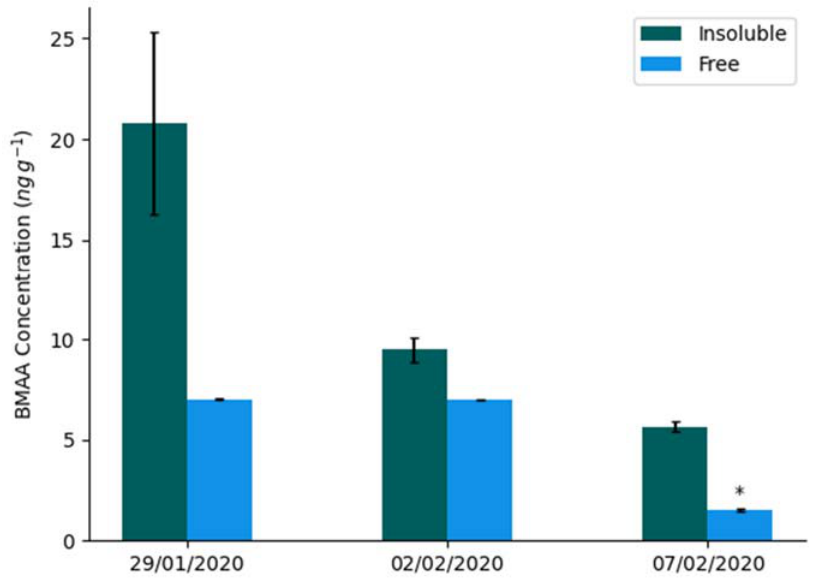
Figure 1. BMAA concentrations ± standard deviation in environmental cyanobacteria samples ( n = 3, n = 6 for 7 February 2020 with combined decayed and the intact results). * Denotes an estimation of concentration, as this sample was detected, but below the LOQ.